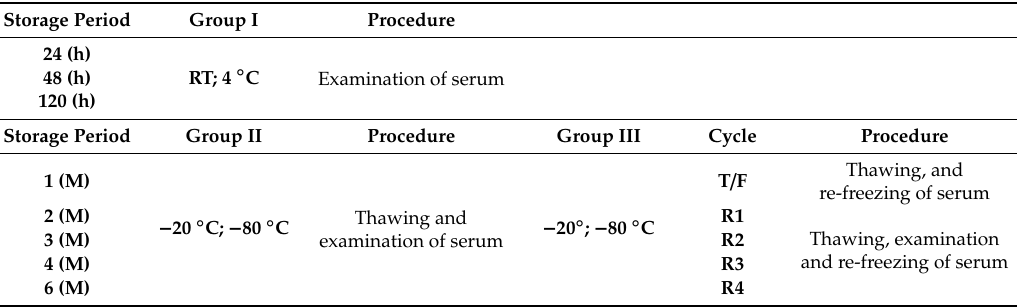
Table 1. Algorithm of study serum samples